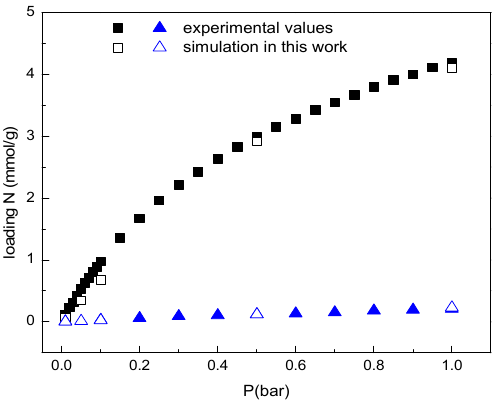
Figure 1. Adsorption isotherms of single CO 2 (squares) and N 2 (triangles) in bio-MOF-11 at 298 K (filled symbols represent experiment values from literature and open symbols represent the results from the current simulation